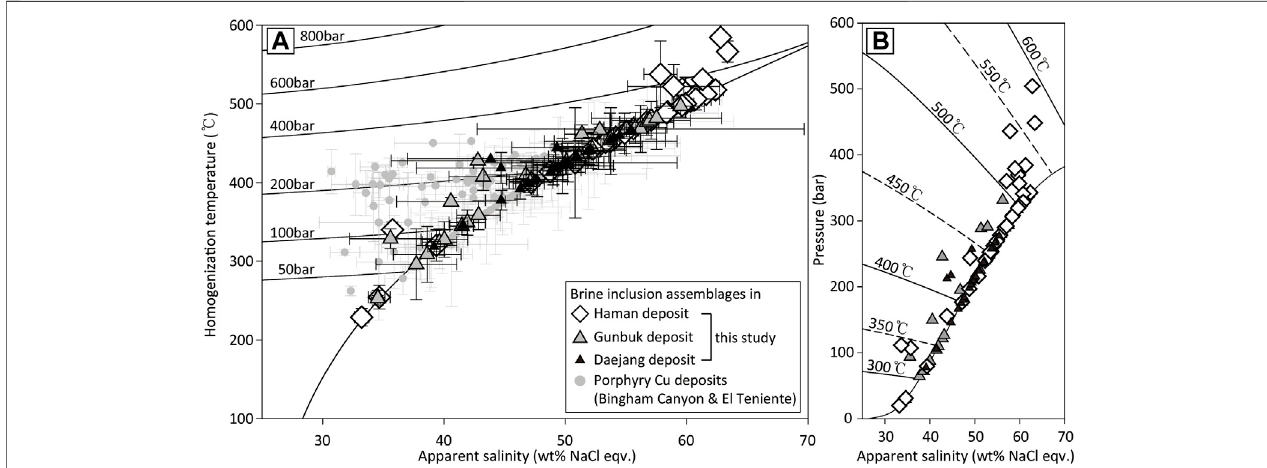
FIGURE9|(A) Plotsofhomogenizationtemperaturesversusapparentsalinities(NaClwt.%equivalents)obtainedfrombrineassemblagesoftheHaman,Gunbuk,Daejang depositandporphyry-styledeposits(BinghamCanyon&ElTenientedeposit)(Klemmetal.,2007;Landtwingetal.,2010).Thegraycirclesrepresentporphyrydeposits,thewhite diamonds represent the Haman deposit, the gray triangles represent the Gunbuk deposit, and the black triangles represent the Daejang deposit. Ranges of the Gunbuk and Daejang deposits partially overlap with porphyry deposits, maximum temperatures were exceptionally higher in the Haman deposit than in porphyry deposits. (B) Plots of salinityversuscalculatedpressureforbrineinclusionassemblagesinthethreedeposits.Thecirclesrepresentliquidinclusionassemblages,andtherhombusandtrianglesymbols representbrineinclusionassemblages.WhitecirclesandrhombussymbolsrepresentT h andsalinityoftheHamandeposit,graycirclesandtrianglesrepresentT h andsalinityofthe Gunbuk deposit, and black circles and triangles represent T h and salinity of the Daejang deposit.